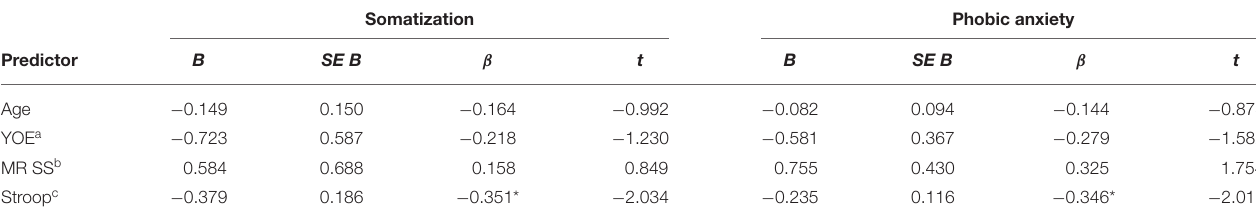
TABLE 3 | Multiple linear regression analyses for cognitive-executive variables predicting SCL-90-R symptom scale scores in female premutation carriers. Somatization Phobic anxiety